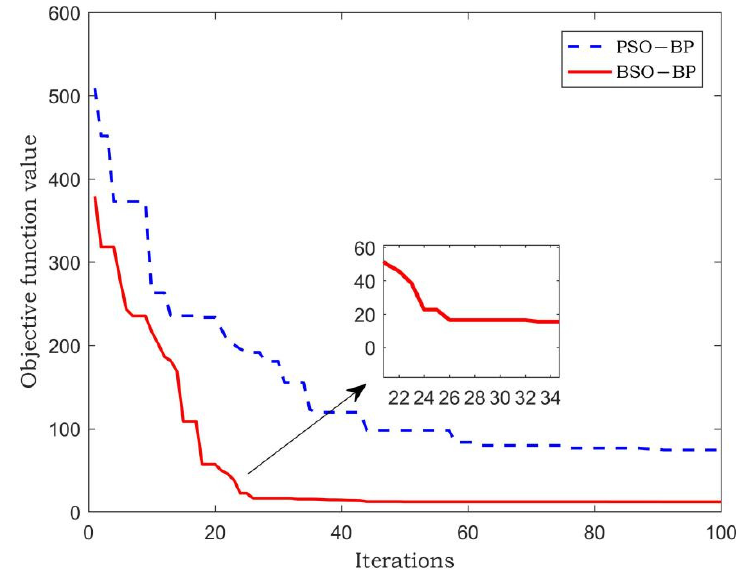
Figure 8. Iterative comparison of fitness function values for gross weight.